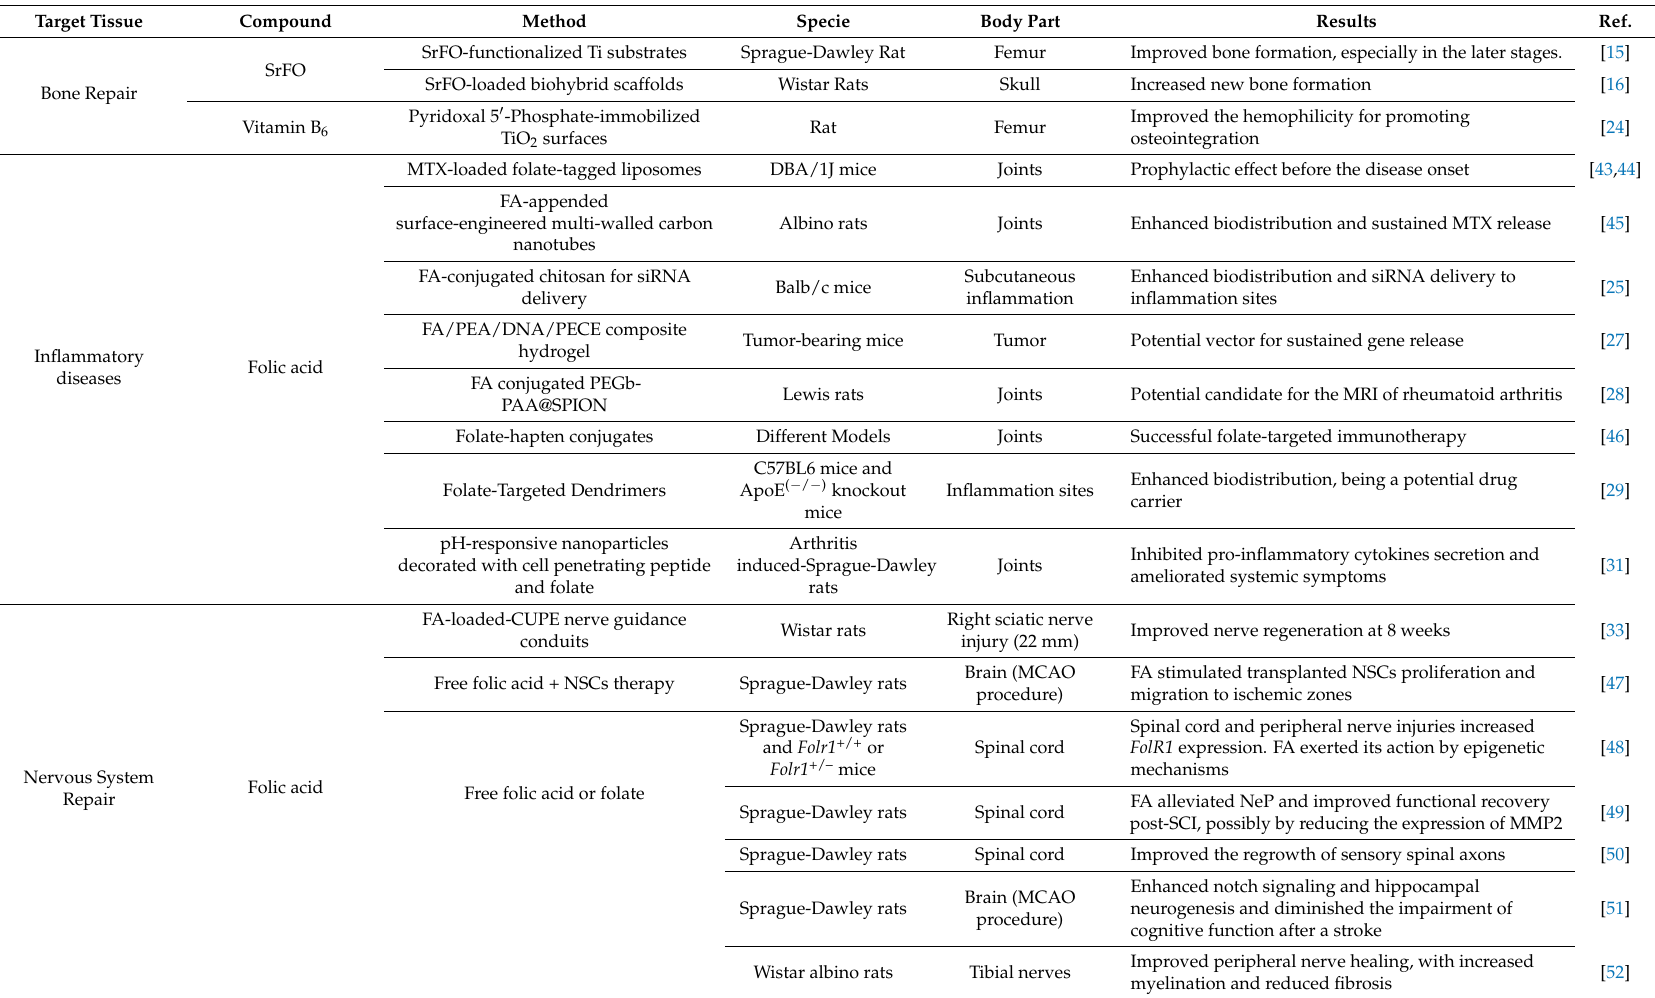
Table 2. In vivo studies using B-vitamins-based regenerative